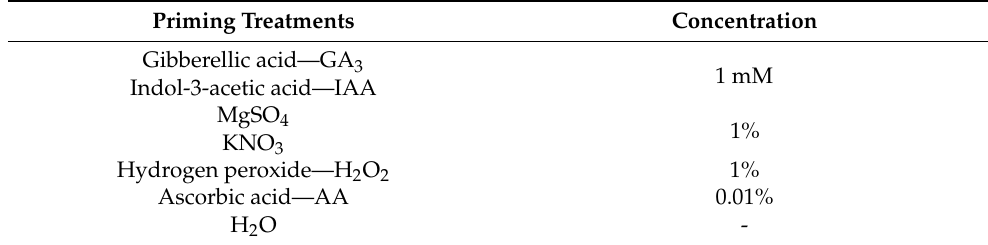
Table 5. Summary of the applied priming